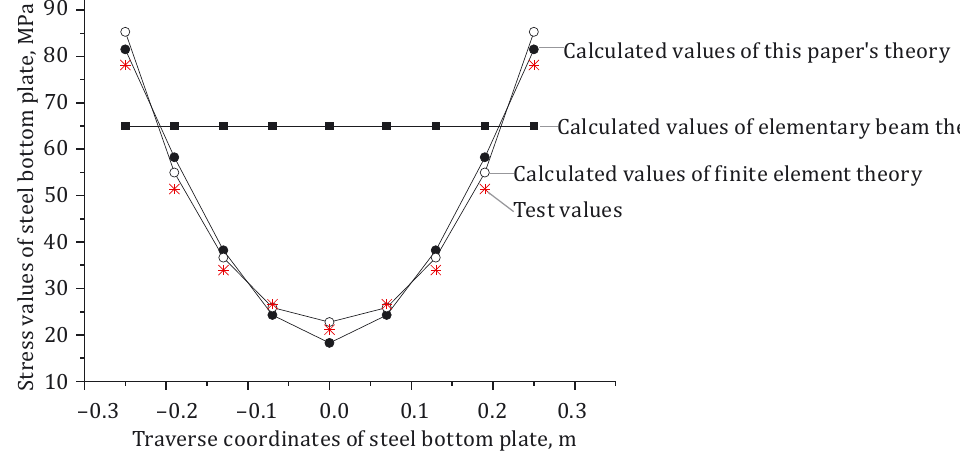
Figure 7. The stresses of steel bottom plate under the concentrated load Traverse coordinates of steel bottom plate,